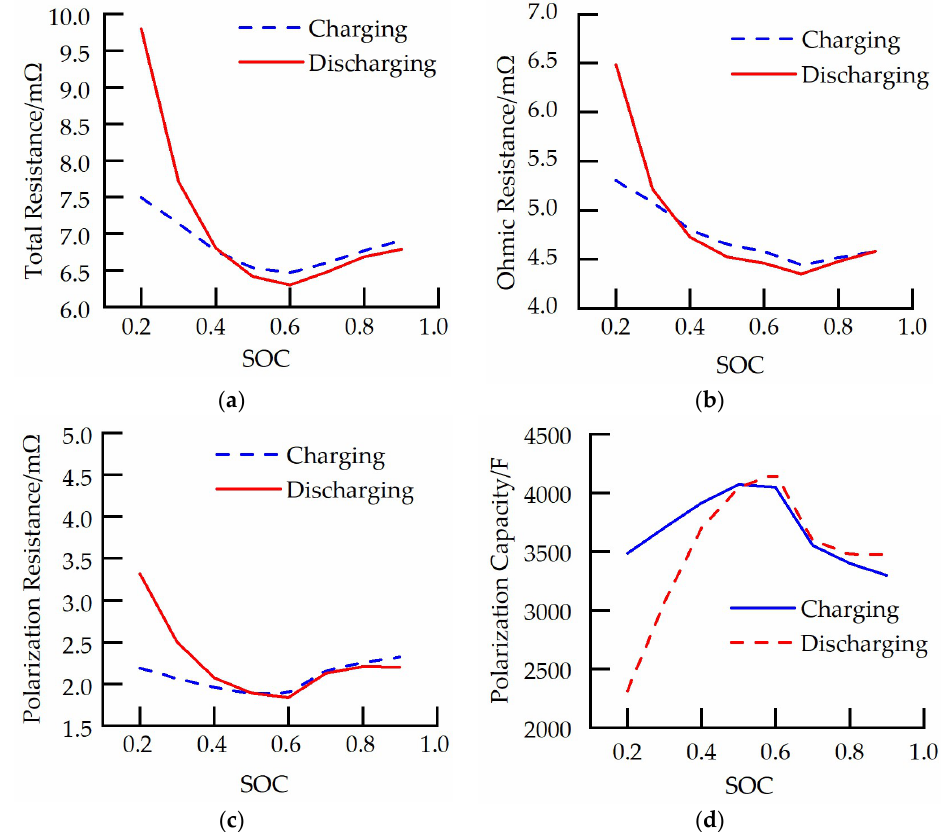
Figure 3. Relationship between OCV and BSOC. The hybrid pulse power characterization (HPPC) test was used to acquire the data to identify the parameters of polarization capacitance, charge and discharge resistance, which is shown in Figure 4.